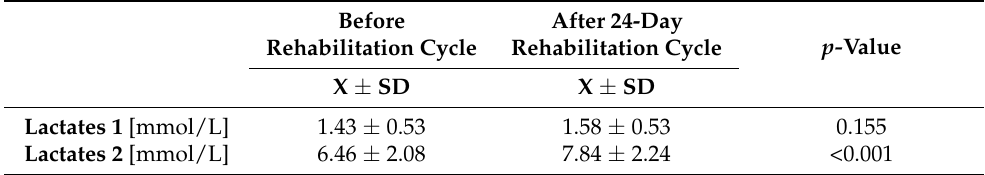
Before Rehabilitation Cycle